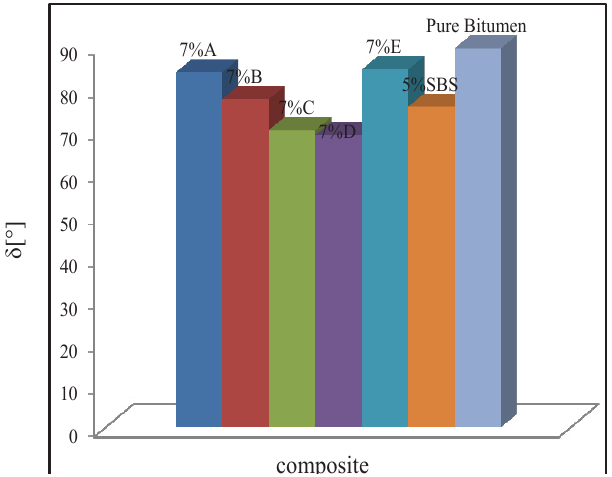
Fig. 8. Phase angle shift of the pure bitumen and the modified ones at 80.1 o